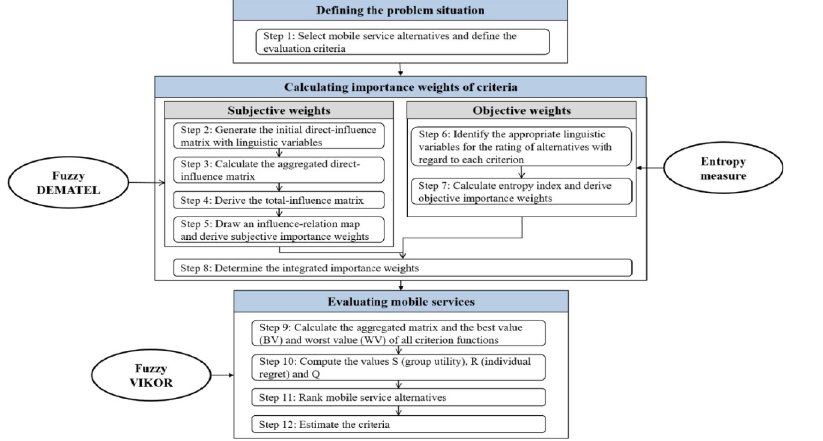
Fig 3. Overall research